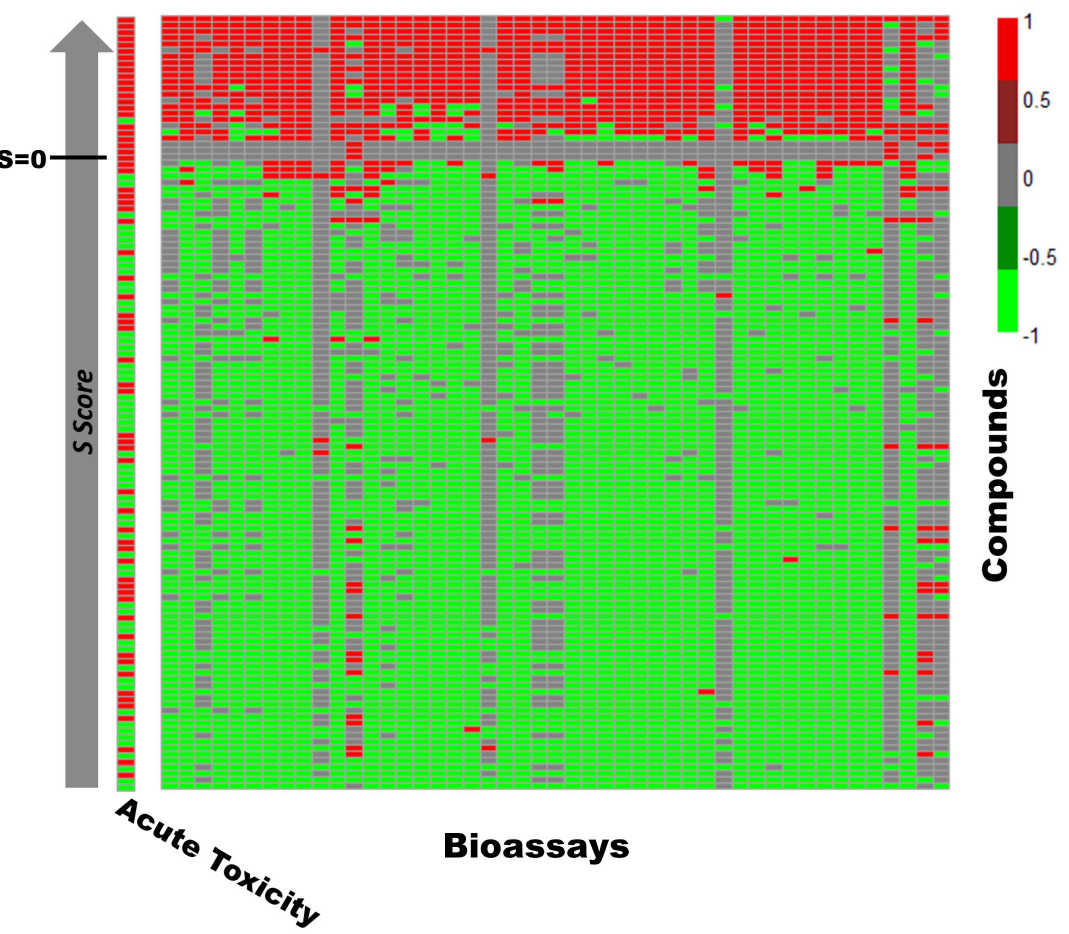
Figure 5. The reorganized heat map for the response profiles of 123 compounds against 47 bioassays. The left separated column shows the animal acute toxicity for each compound.